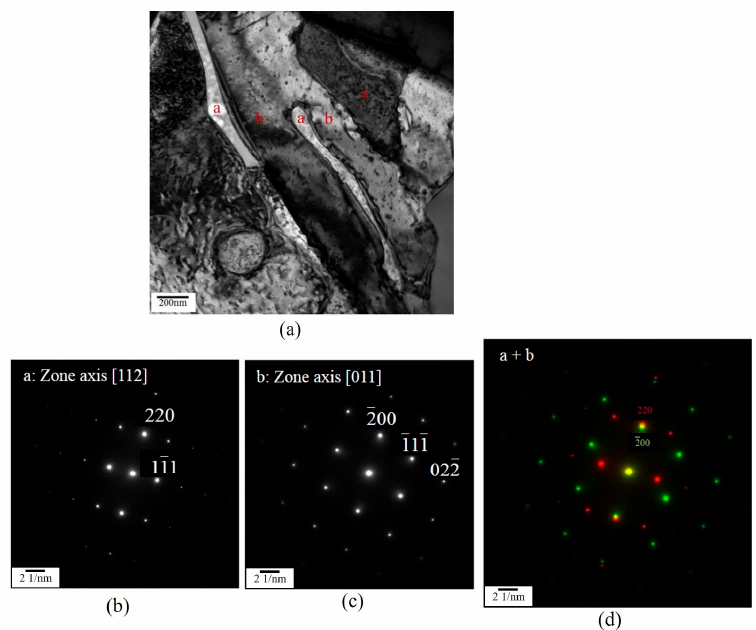
Figure 9. Coherence between Mg 2 Si and the Al matrix. ( a ) morphology of Mg and Si-rich globule boundary; ( b ) diffraction patterns of phases a ; ( c ) diffraction patterns of phases b ; ( d ) merging diffraction patterns of phases a and b.